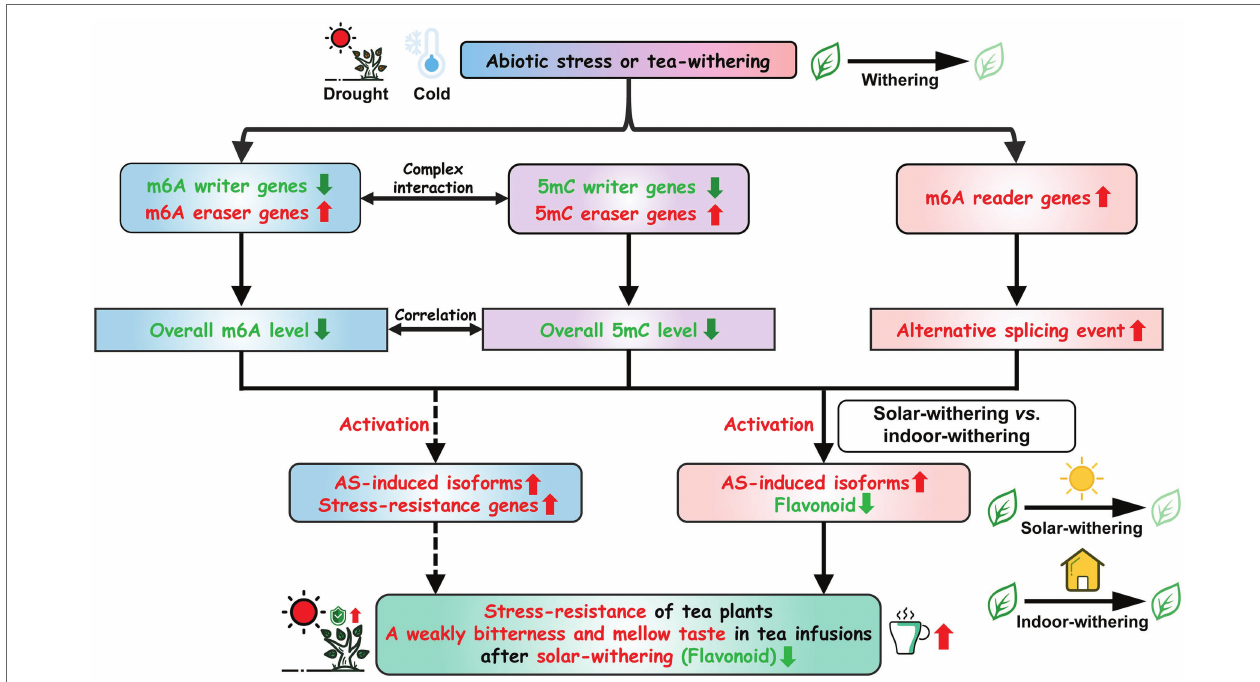
FIGURE 13 | Schematic model for the roles of m6A regulatory genes in tea plants under abiotic stresses and tea-withering. Arrows represent the direct interaction; dotted arrows represent the indirect